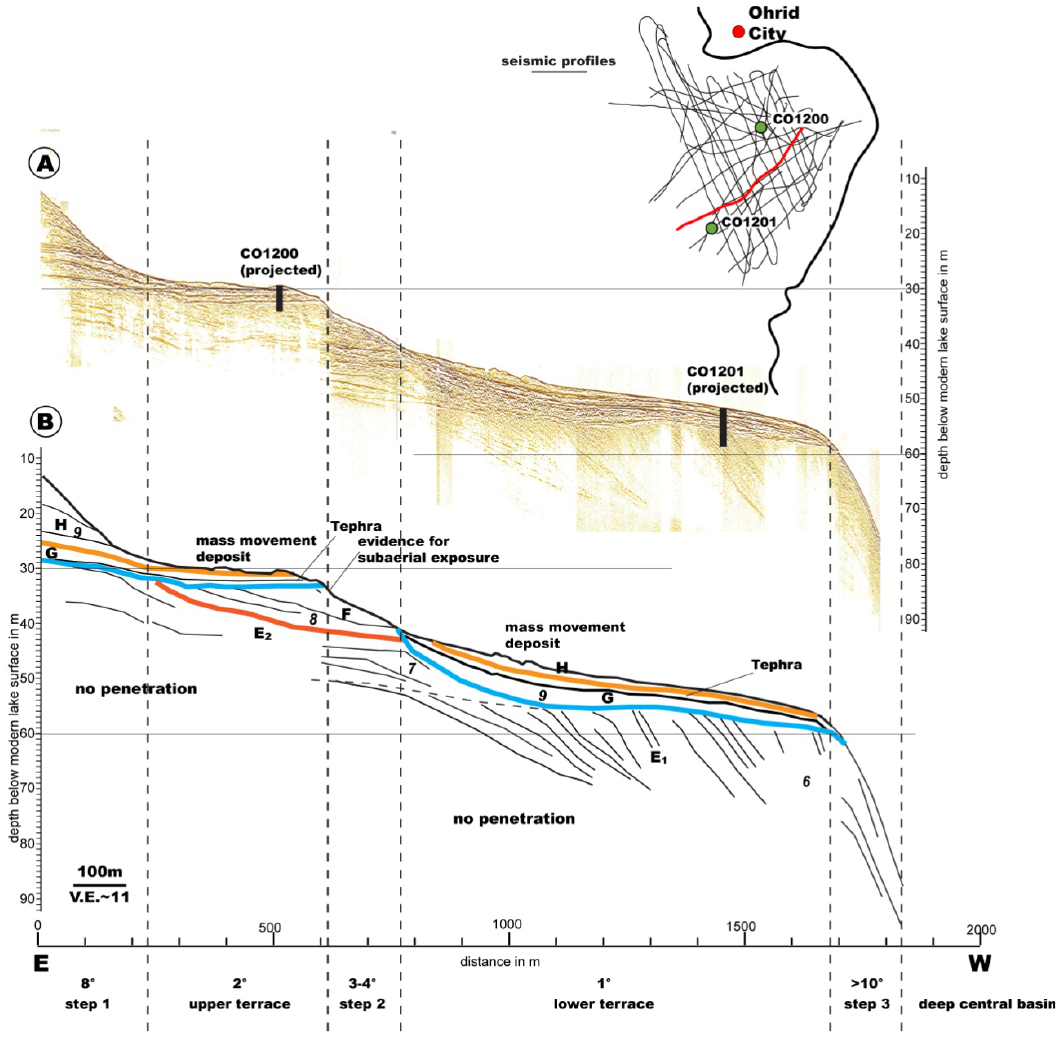
Fig. 4. East-west directed sediment echosounder line across Ohrid Bay over a distance of 2 km (see map inlet for location). (A) Uninterpreted section with projection of sediment cores (B) line drawing and interpretation of the section (colors indicating the base of each seismic unit are the same as colors used for Lithofacies in Figs. 5, 6). The profile shows the internal structure of the upper and lower terraces. Seismic units E 1 , E 2 F, G, H and System tracts 6, 7, 8, 9, a tephra layer most likely assigned to (CI)/Y5 and areas with mass wasting deposits as evidenced by a hummocky topography are labeled. Slope angles are indicated at the bottom of the line drawing.